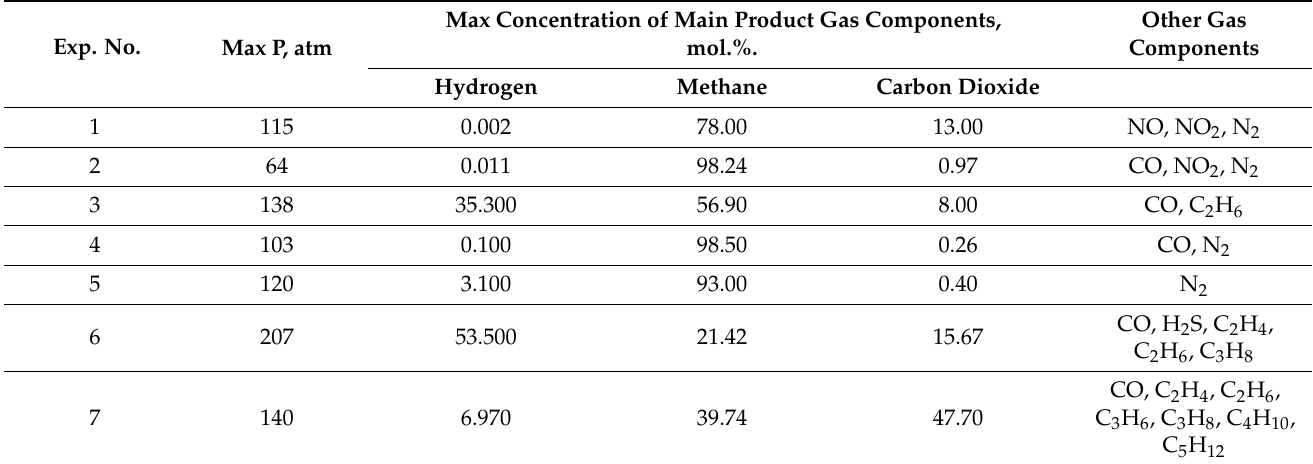
Table 4. Summary of experimental parameters and product gas composition.